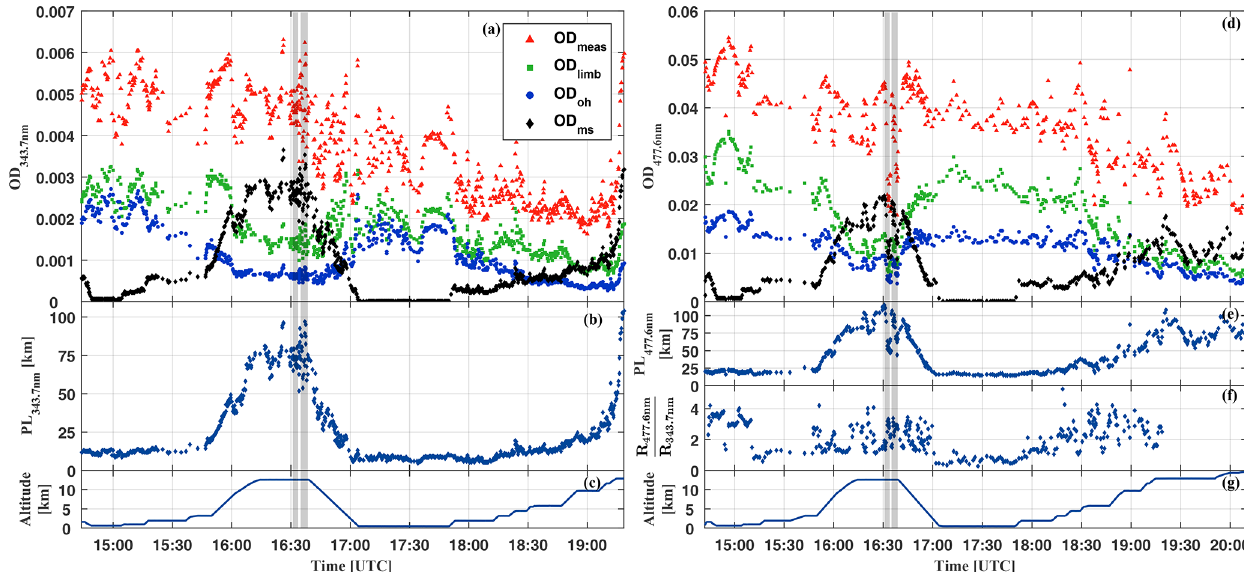
Figure 2. Attribution of the total measured optical depth of O 4 at 343.7nm (a–c) and at 477.6nm (d–g) to the various fractions, i.e. absorption from overhead at the aircraft (OD oh ), from multiple scattering below the aircraft (OD ms ), within the line of sight of the telescopes (OD limb ), and the total measured optical depth of O 4 (OD meas ) for the HALO flight on 16 September 2014 (AC11) (a, d) . The average line-of-sight photon path length inferred from the measured OD meas at 343.7 and 477.6nm, respectively, as a function of the flight time is plotted in (b, e) . The colour ratio R 343 . 7 of the measured radiances at 343.7 versus 477.6nm is shown in (f) . The flight trajectory of the HALO aircraft is R 477 . 6 shown in (c, g) . The sharp drop of the optical depth between 16:32–16:3 and 16:35–16:39UTC (grey bars) coincides with the passage of a cumulonimbus cloud in front of the telescopes. For details see the text.